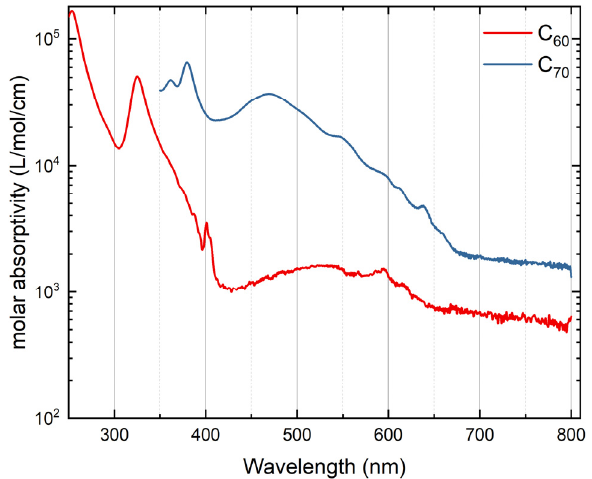
Figure 2. Log-scale molar absorptivity spectra: (solid red line) C 60 in n -hexane, 63.6 µM; (solid blue line) C 70 in benzene, 47.6 µM.